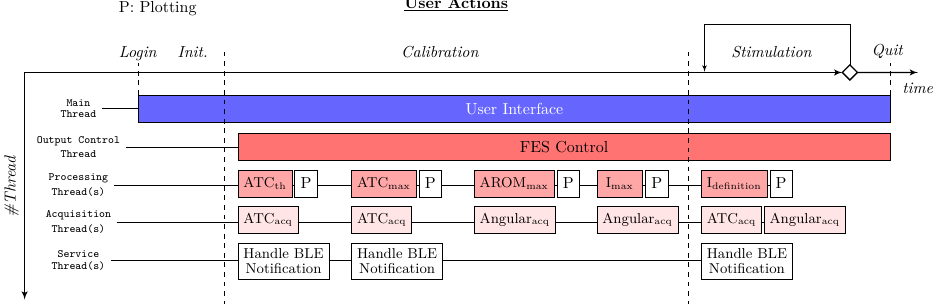
Figure 6. Multi-threading structure during a typical stimulation